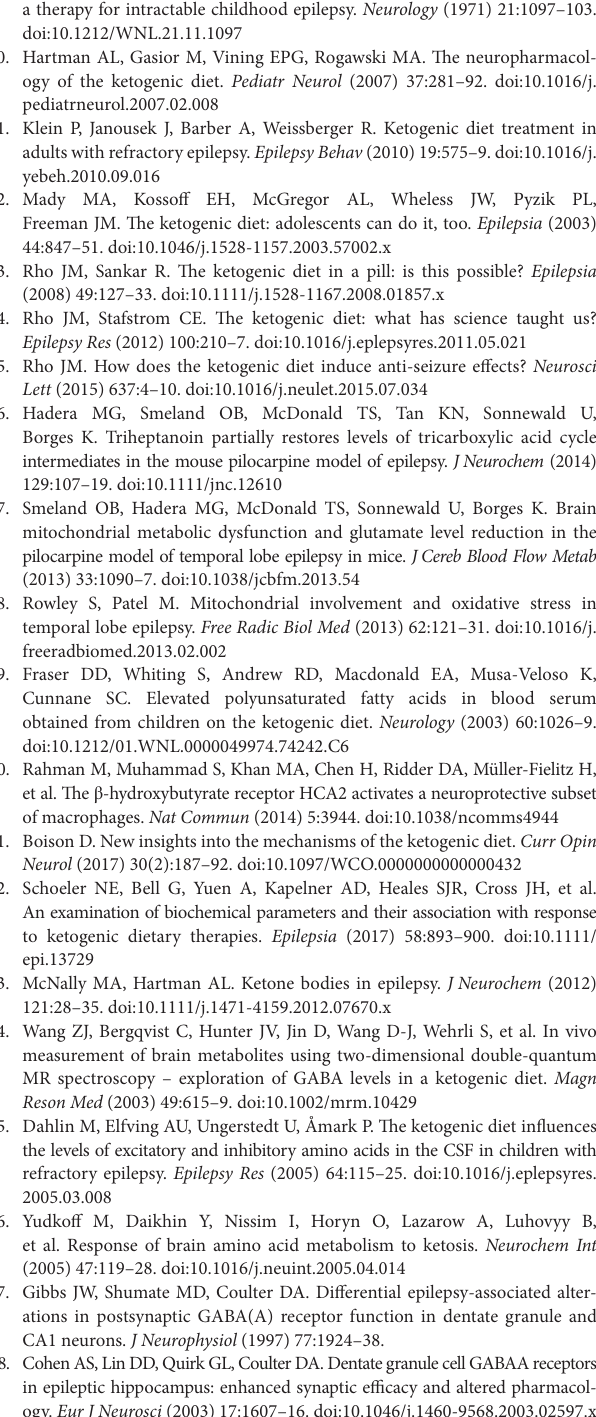
FigUre s1 | Assignments in an nuclear magnetic resonance spectrum of the discriminant metabolites resulting from the groups [control (C), responder (R), and non-responder (NR)] comparison. (1) 3-OH- butyrate; (2) lactate; (3) alanine; (4) acetate; (5) acetone; (6) acetoacetate; (7) glutamate; (8) citrate; (9) choline; (10) glucose; (11) scyllo-